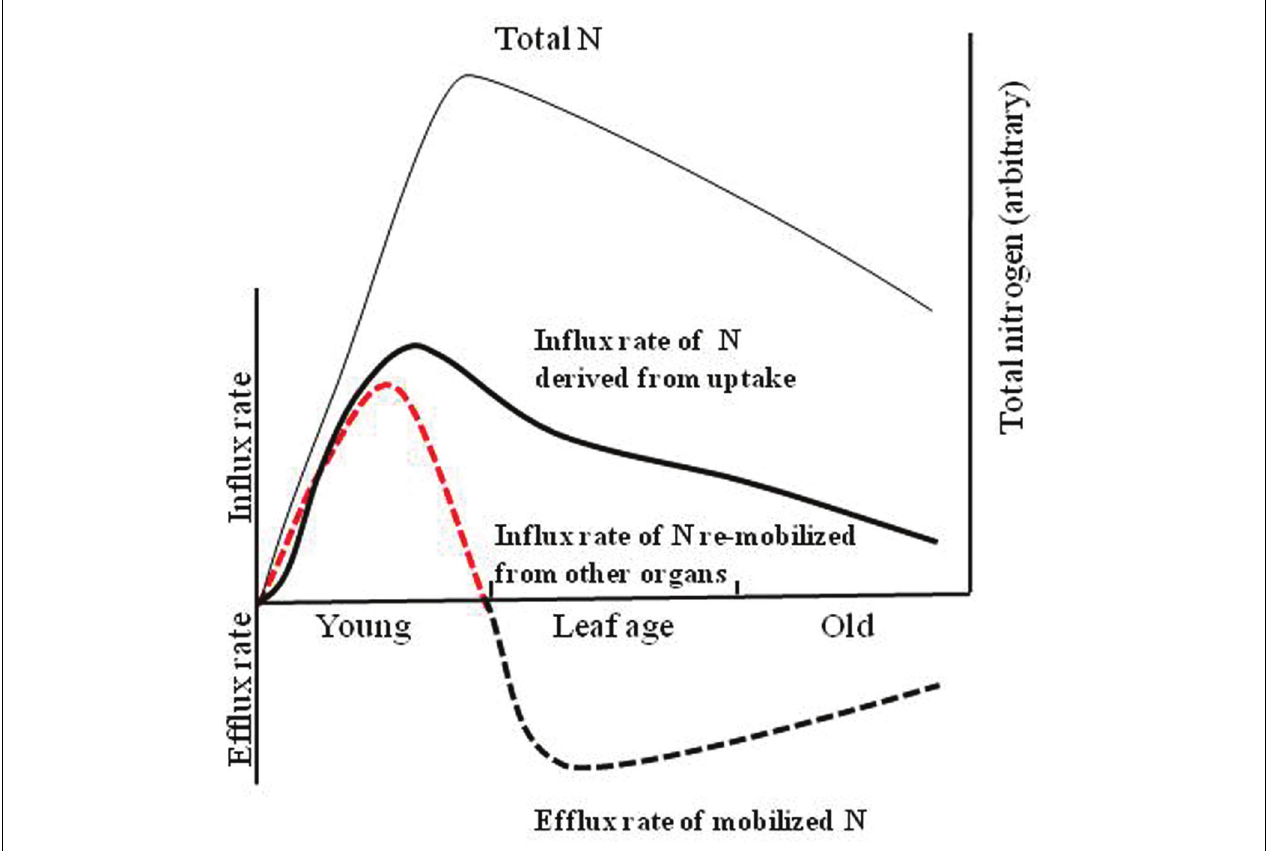
FIGURE 4 | Modeling of the influx rates of N re-mobilized from other organs and N derived from uptake and efflux rate of mobilized N with reference to the total N content of a leaf. Adapted from Yoneyama and Sano